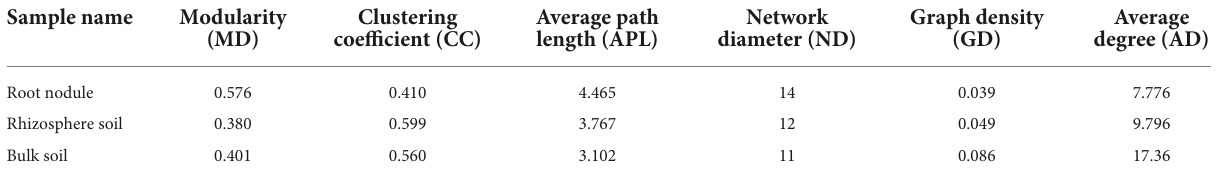
TABLE 5 Topological properties of co-occurring